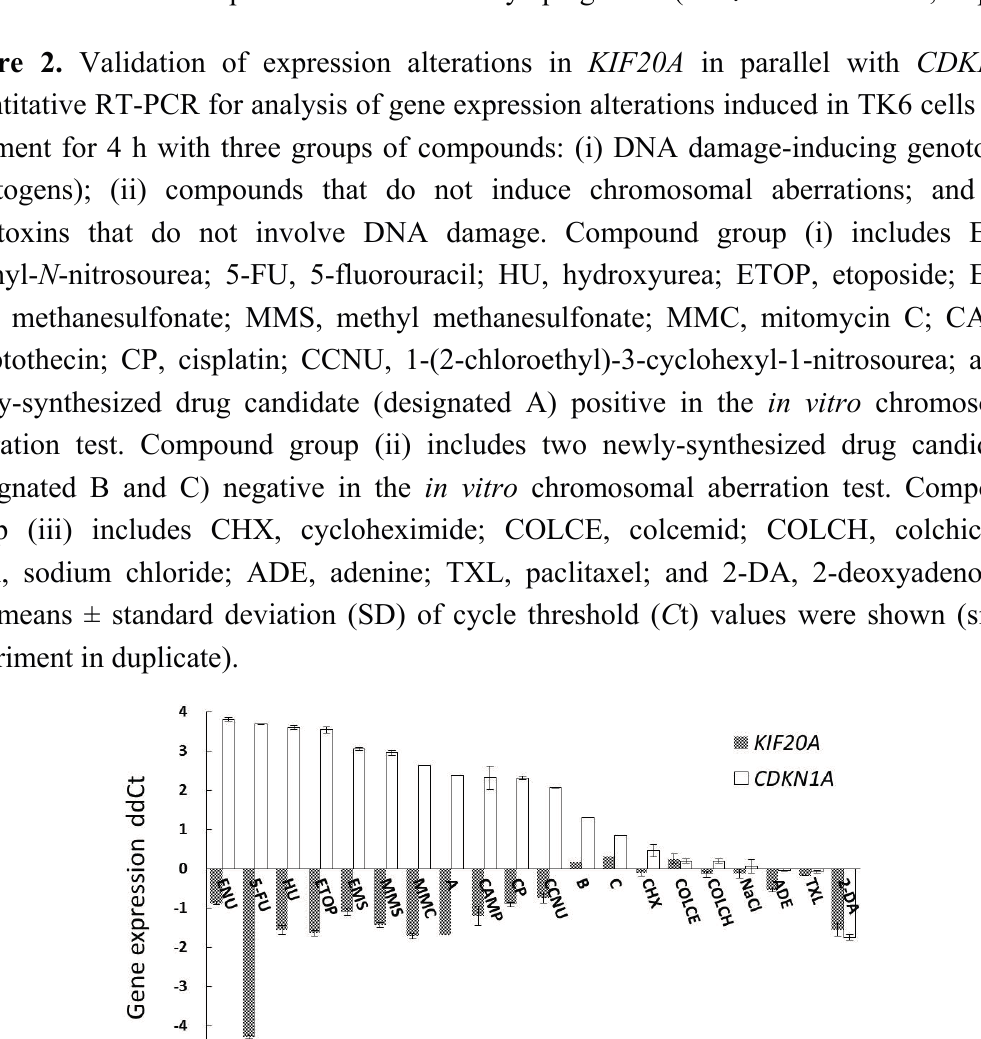
Figure 2. Validation of expression alterations in KIF20A in parallel with